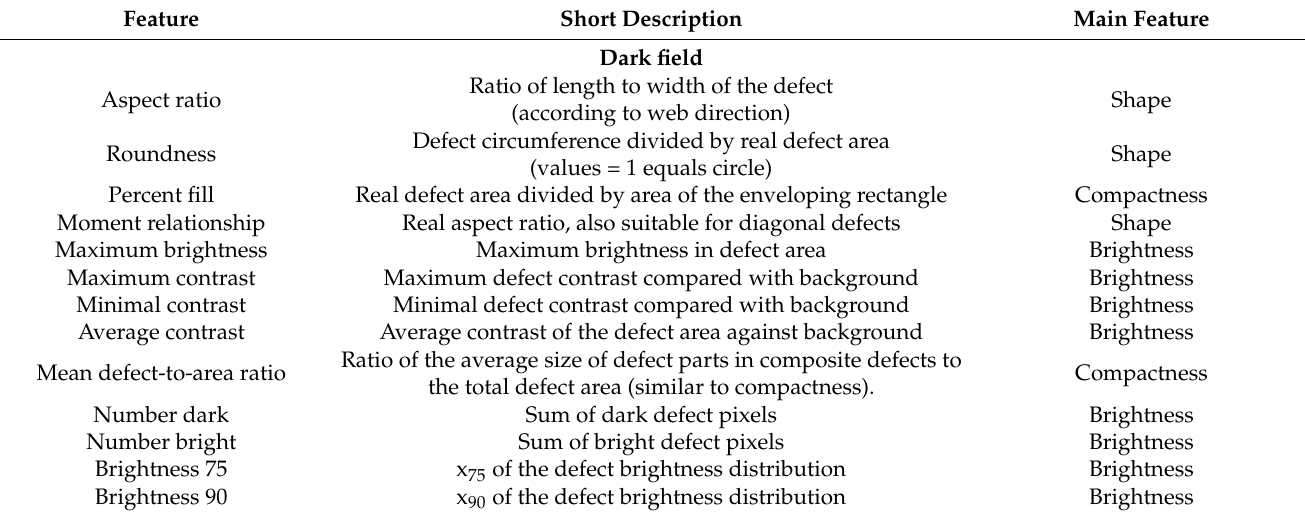
Table 2. Selected investigated defect features used by the algorithm for automated defect